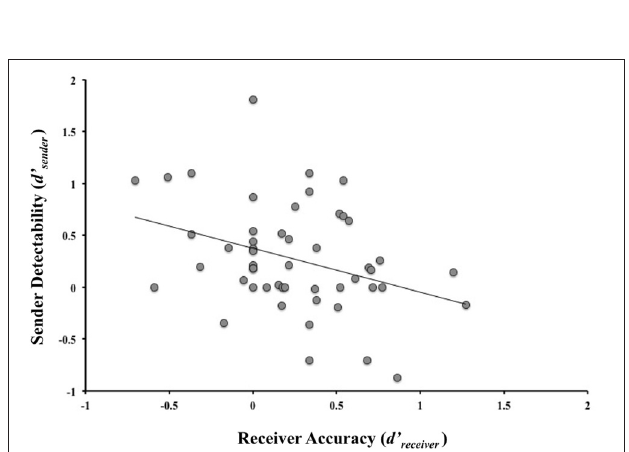
FIGURE 2 | Correlation between Sender and Receiver performance using SDT measures for Receiver Accuracy ( d (cid:2) Receiver ) and sender detectability ( d (cid:2) Sender ) ( r = − 0 . 348, p = 0 . 006, d = 0 . 742).